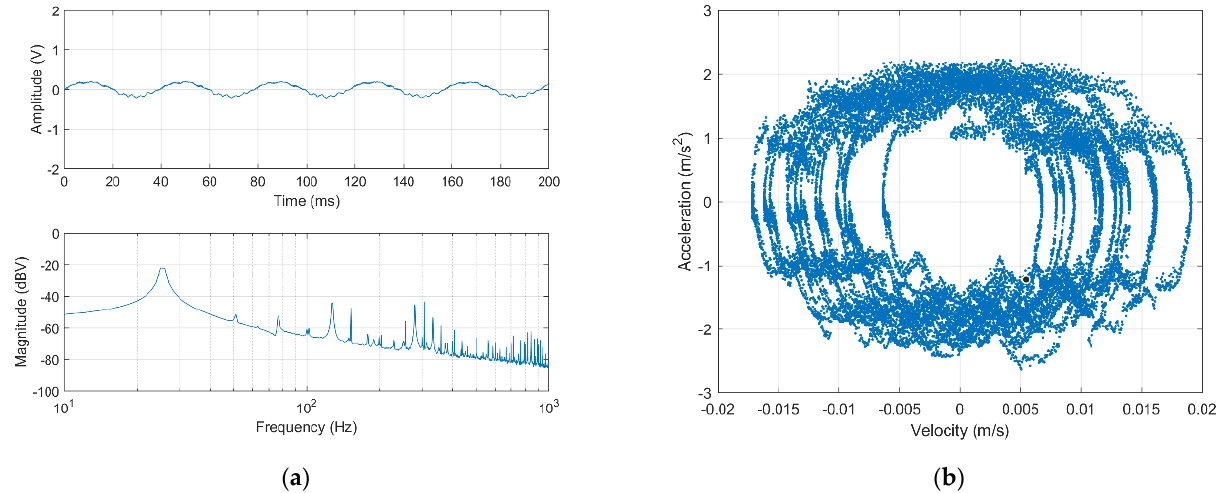
Figure 8. PEH excited by a sinusoidal wave with an amplitude of 5 V and frequency of 25.6 Hz: ( a ) voltage-time response and its Fourier transform; ( b ) experimentally measured phase portrait. The acceleration as a function of time and its Fourier transform are shown in Figure 8a.